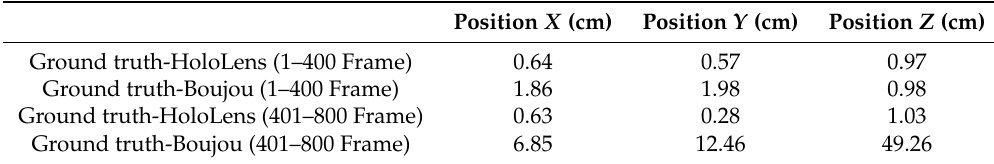
Table 1. Standard deviation of the comparison of ground truth, HoloLens and